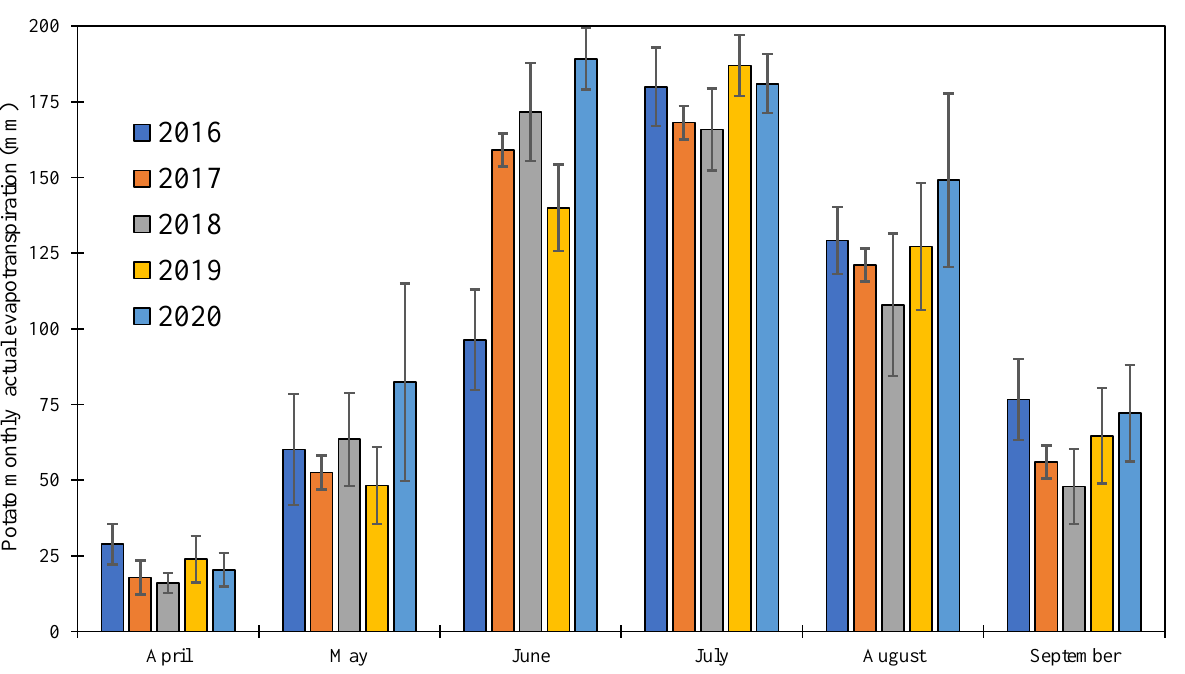
Figure 6. Monthly actual potato crop evapotranspiration with standard deviation among twenty-two potato fields for the 2016 – 2020 period under center-pivot irrigation. Dry beans ’ monthly ETa followed similar patterns as those of maize and potatoes and averaged 21.4, 55.9, 78.3, 135.4, 124.2, 66.4, 45.0, and 25.8 mm for April, May, June, July, August, September, October, and November, respectively (Figure 7). Very few fields are planted with dry beans in April, as the last spring killing frost, which usually occurs in May, could damage the young plants of the dry beans, which may not recover, as their growing point may be destroyed by the frost in contrast to the monocotyledons (maize), which may still have their growing point situated below the soil surface of similar growth stage [23]. Therefore, the crop ETa of April is soil water evaporation and the evapotran- spiration of weeds before field preparation and could be ignored in the management plan- ning objectives. Dry beans are short-duration crops, and the harvest usually starts in Sep- tember and continues to October – November depending on the planting date, which is echeloned in late April to late June and early July, and sometimes at the NAPI, based on the availability of equipment or personnel, drying equipment such as a silo is used with a drying system. Thus, the dry beans ’ ETa estimates vary across fields and planting dates. For planning purposes, dry bean crop season could be considered for the May – October period. The estimated dry bean seasonal ETa averaged 512.8 ± 46, 484.9 ± 39, 505.6 ± 67, 507.4 ± 59, and 520.0 ± 60 mm for the growing seasons of 2016, 2017, 2018, 2019, and 2020, respectively.